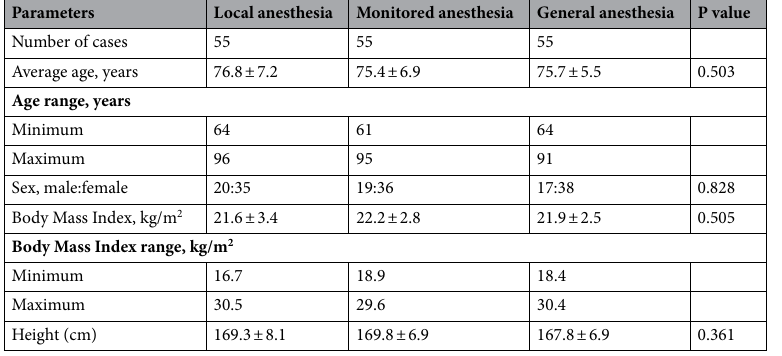
Table 1. Baseline demographic. P ≥ 0.05 indicated no statistical